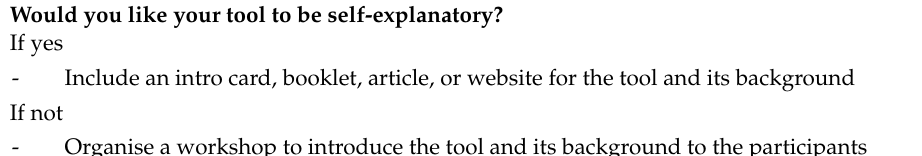
Table 4. Checklist for developing tools for co-designing with OA on behaviour